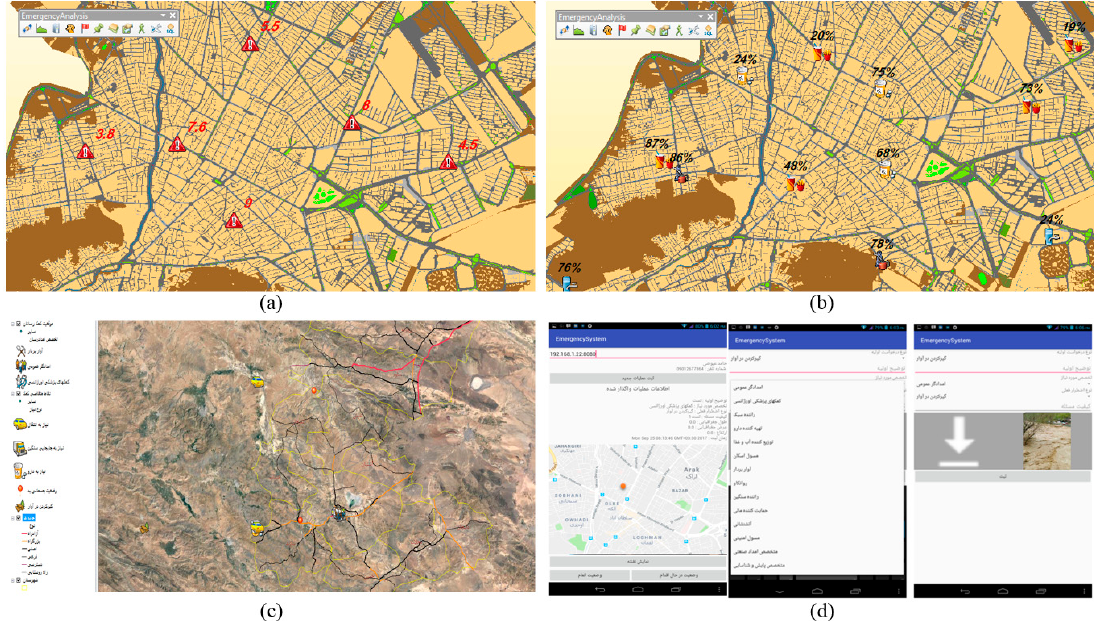
Figure 10. ( a ) Designed analysis for finding system users with long stopping time since crisis occurred, ( b ) Displaying the remaining amount of the critical resources in the graphical user environment, ( c ) A GIS server user, server side, in a web browser with main requests’ types, ( d ) Crowdsourcing mobile user interface and its components.